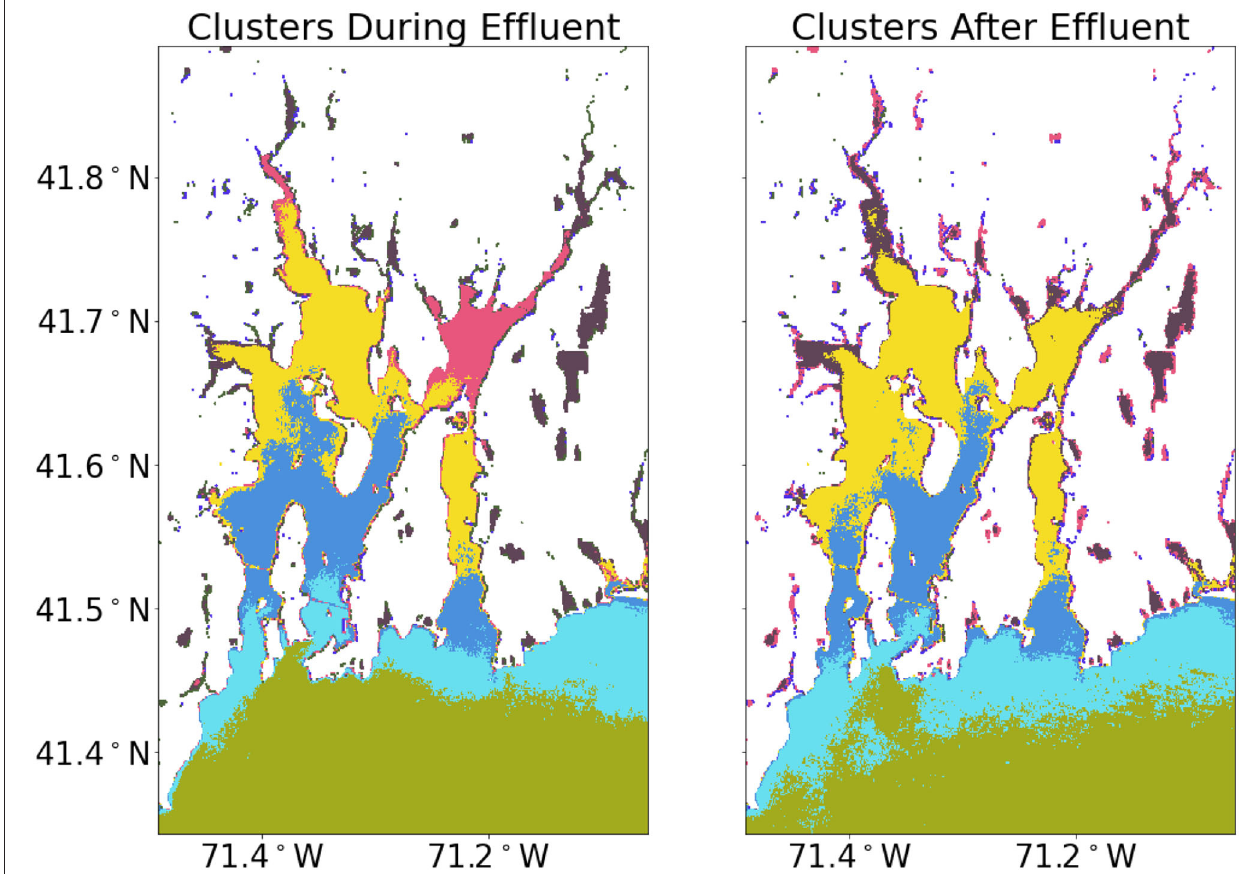
FIGURE 7 | K-means clustering on mean, amplitude, and phase shift coefficients from climatology fitting, as described by Equation (1.2), during and after the BPPS effluent.